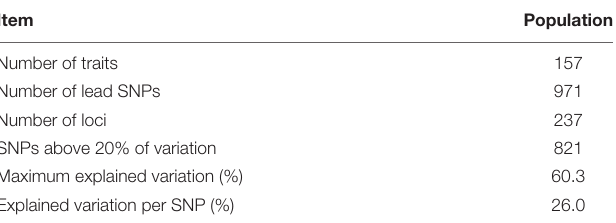
TABLE 1 | Summary of genome-wide significant associations identified in the